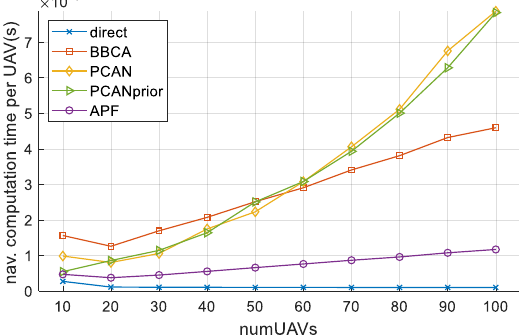
Figure 11. Average time required by the navigation algorithms.